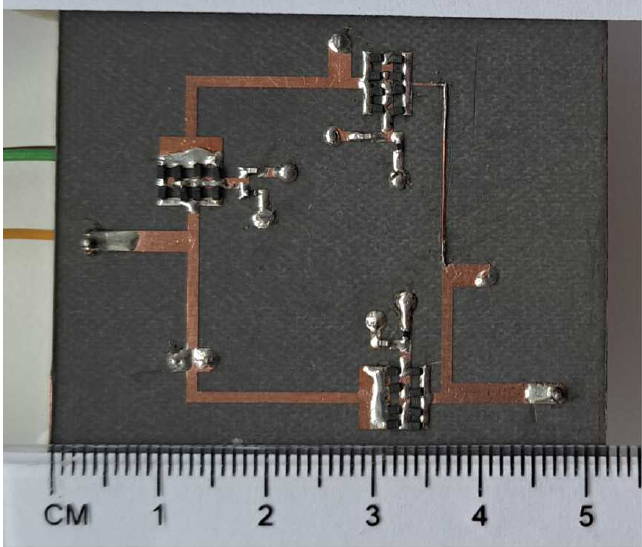
Figure 13. Photo of the fabricated prototype of the triple-tuned filter.